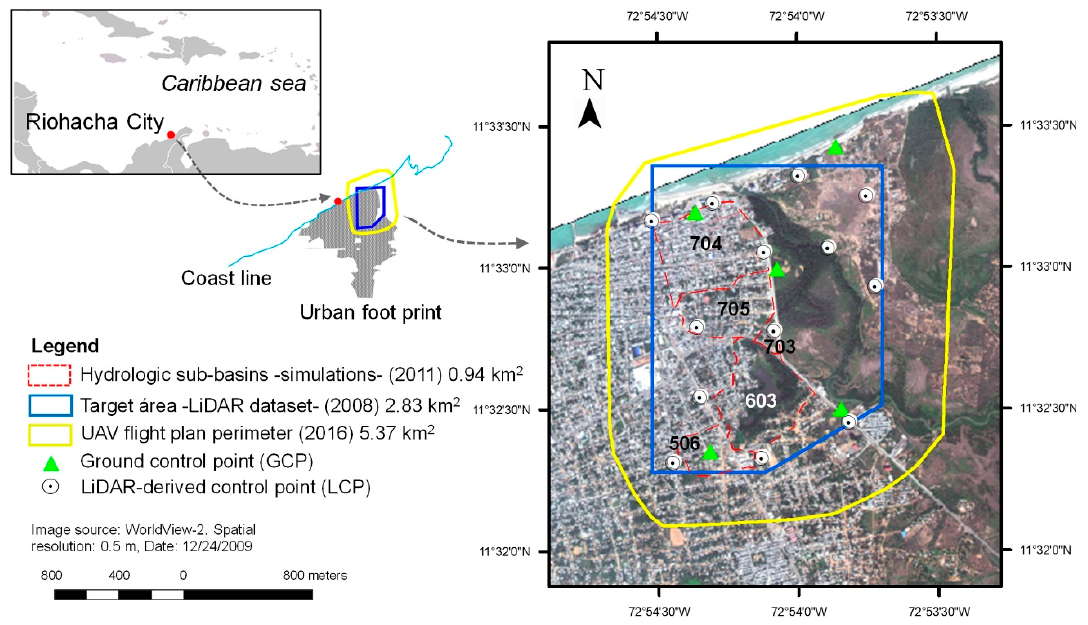
Figure 1. Map of the selected study area and location of control points for DEM generation. Hydrologic sub-basin (red dashed polygons) and numbers (bold type) were delineated and coded from local flood simulations performed by Nardini and Miguez [44].